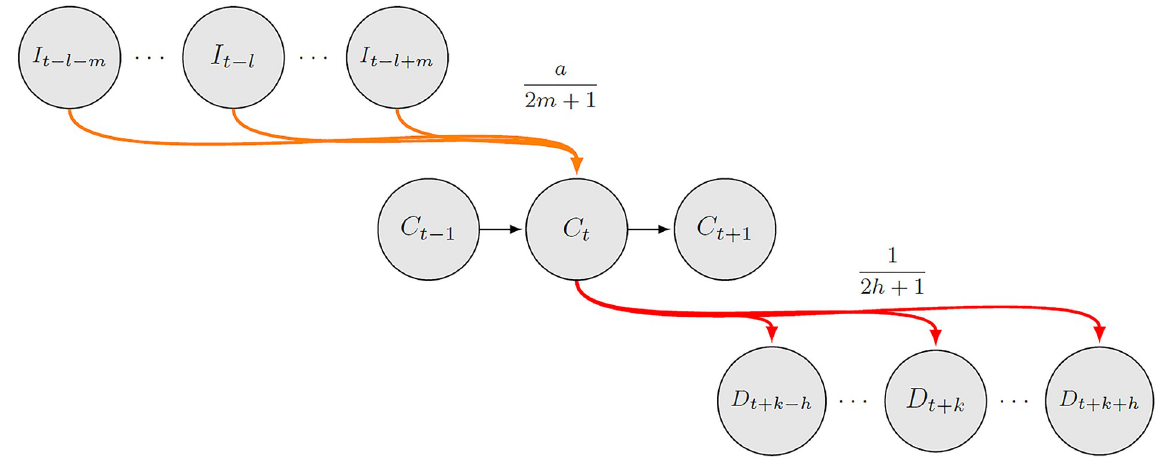
Fig 2. Compartment model